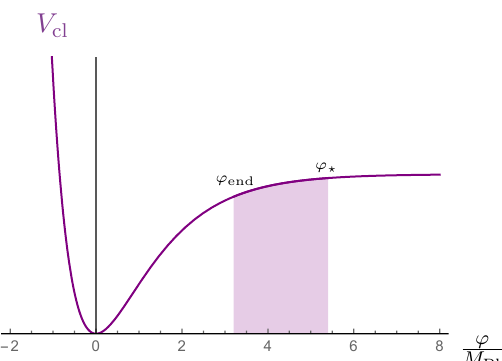
Figure 14 . Pictorial representation of the Starobinsky-like in(cid:13)ationary model for ’ > M Pl subject to the scalar potential in (4.13) with parameter choice m = 7 : 20 (cid:2) 10 11 GeV and 7 : 75 (cid:2) 10 (cid:0) 11 . (cid:21) . 1 : 05 (cid:2) 10 (cid:0) 10